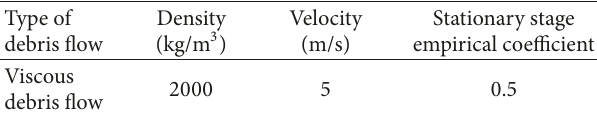
Table 1: The parameters of hydrodynamic pressure of the slurry. Type of Density Velocity Stationary stage debris flow (kg/m 3 ) (m/s) empirical coefficient Viscous 2000 5 debris flow